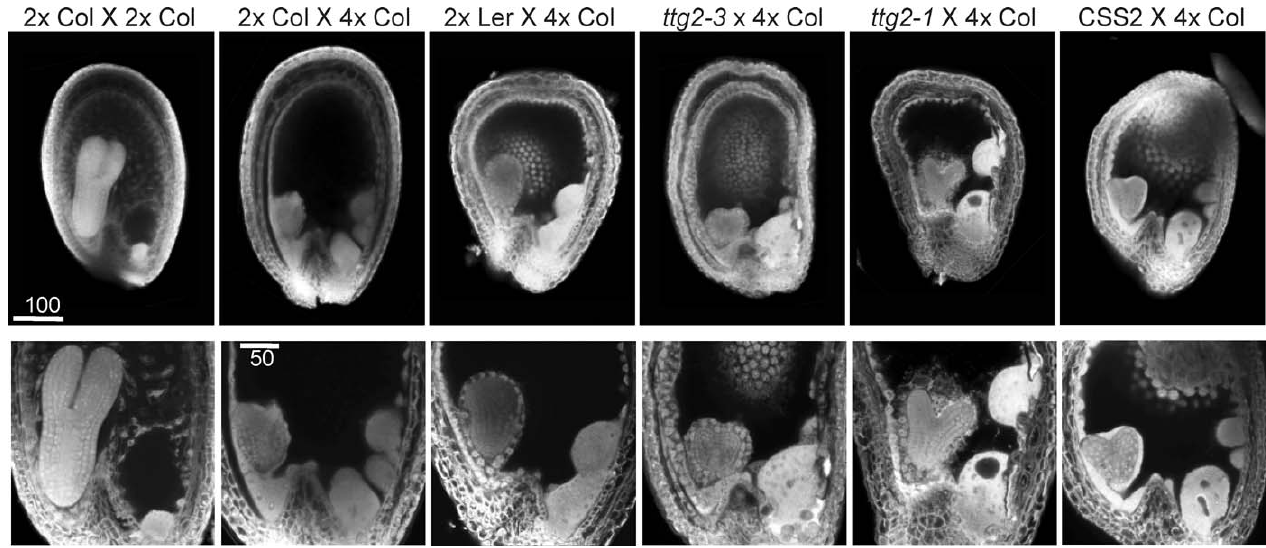
Figure 6. Confocal Photomicrographs of the Endosperm Cellularization Phenotypes of Developing Seeds from 2x 3 2x and 2x 3 4x Crosses at 6 DAP The first row shows full seeds, and the second row shows close-ups of the embryo and surrounding region and the chalazal endosperm. All seeds are oriented with the embryo on the left and chalazal endosperm to the right.